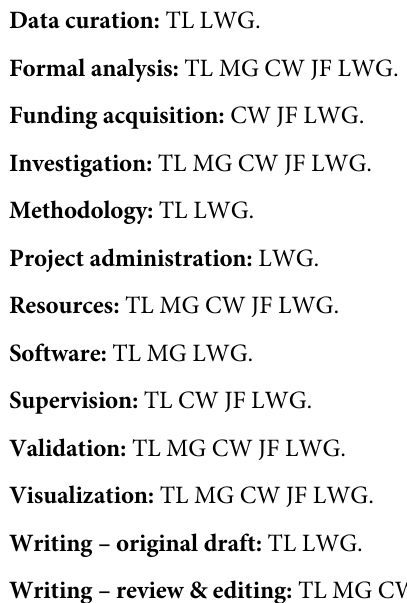
Fig 7. Characterization of the O 2 tunnel. (A) The Sc AHAS structure showingresidues in the vicinity of the tunnel in CC_1. (B) Computationalanalysisof the O 2 channelshowingsolvent accessibility(Green color) and corresponding